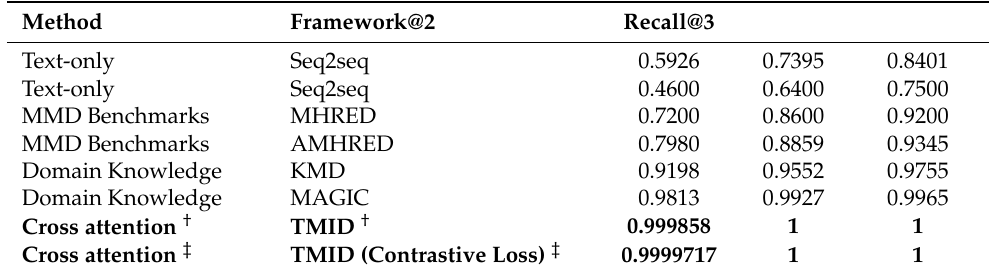
Table 2. Performance comparison between TMID and baseline models on image response